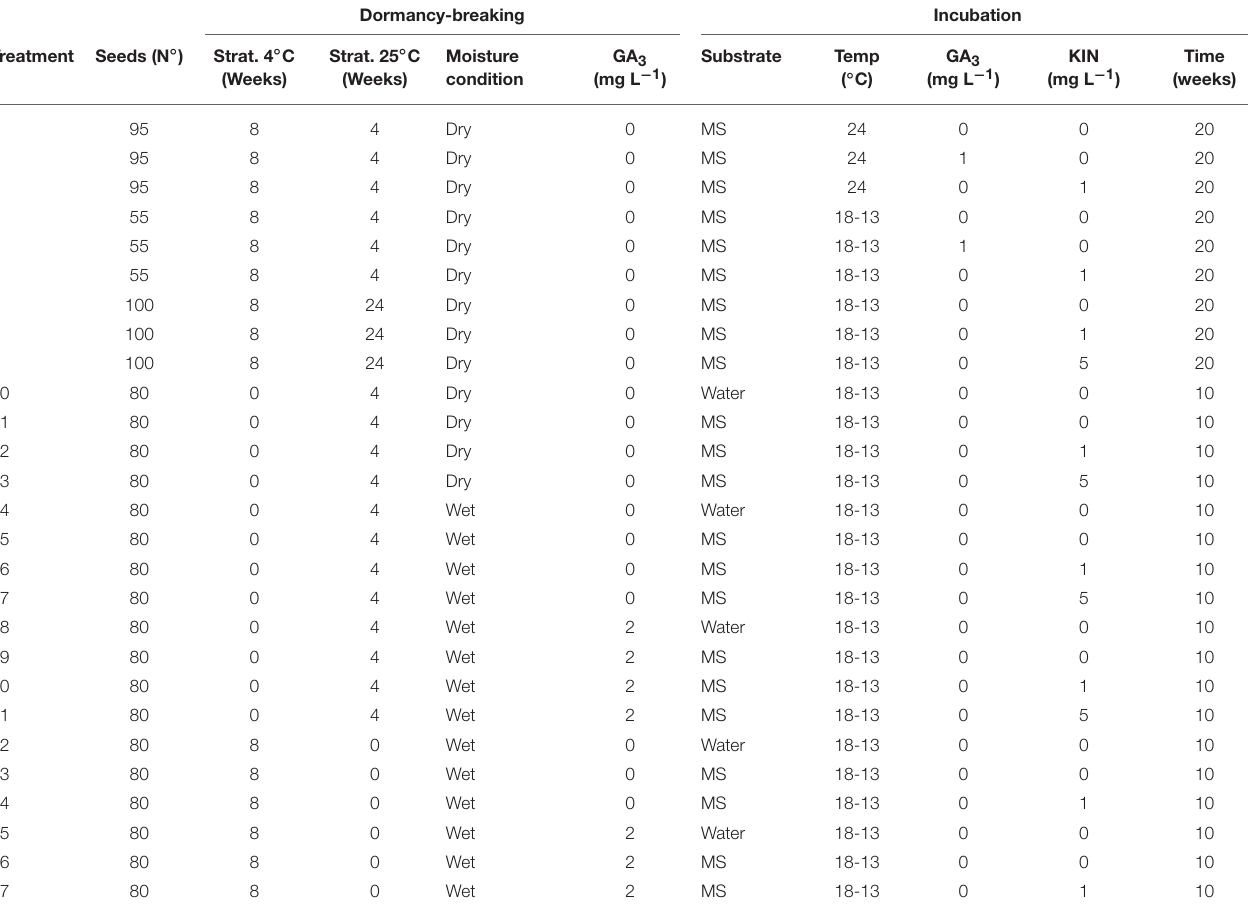
TABLE 1 | Design of Eryngium seed dormancy-breaking and incubation procedures. Dormancy-breaking Incubation Treatment Seeds (N ◦